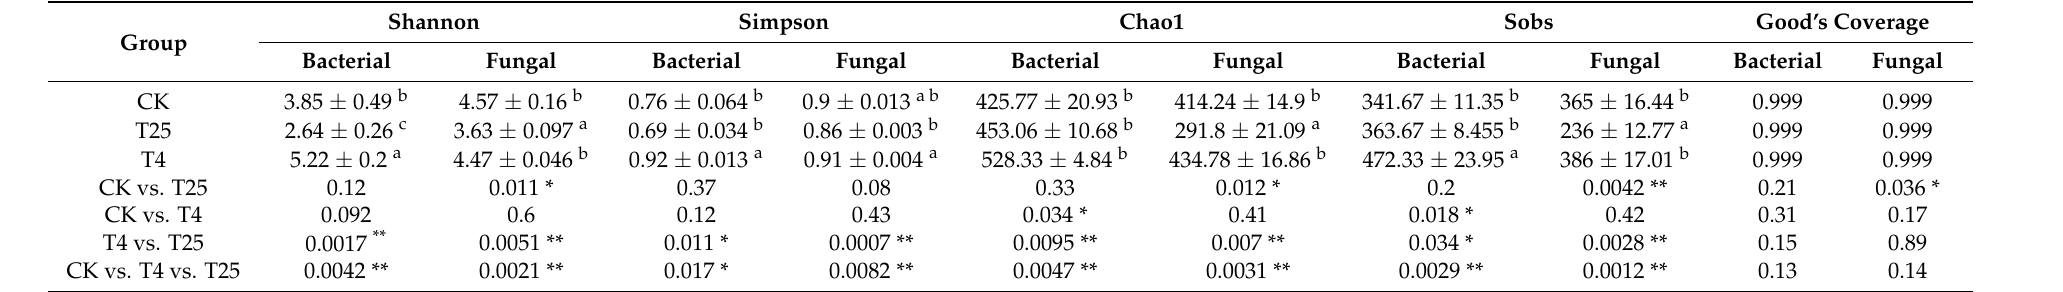
Table 2. Significance analysis of bacterial and fungal α − diversity